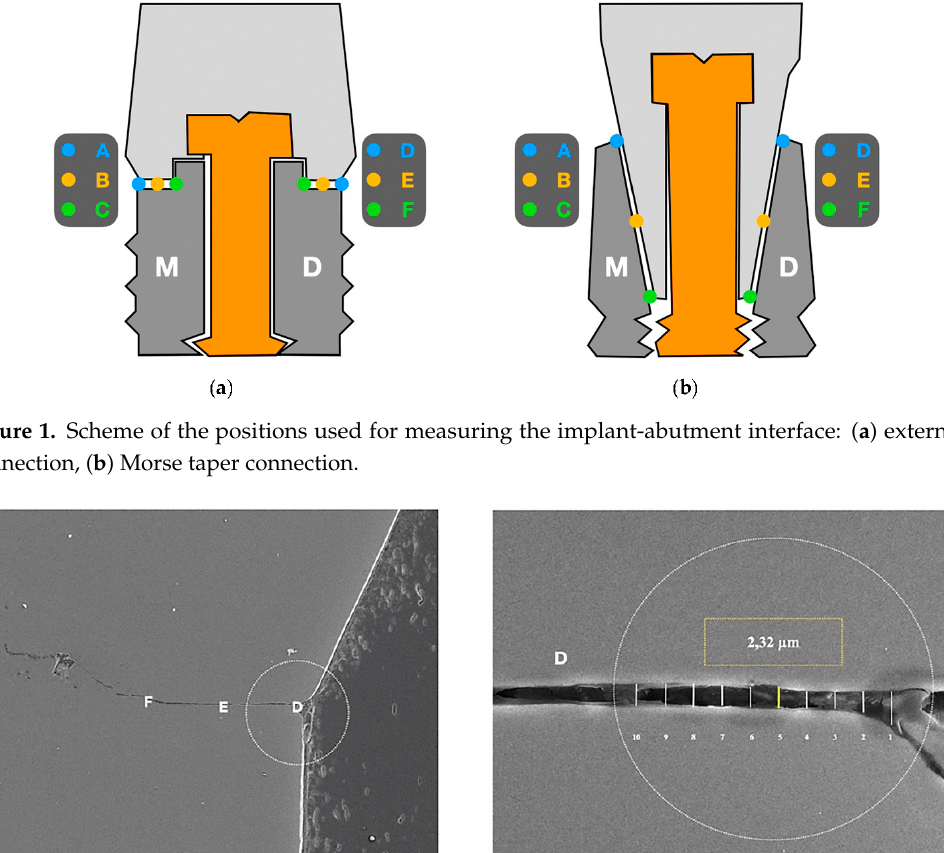
Figure 2. SEM images (1000×): ( a ) Reference points for the measurements in the external connection, ( b ) Detail of an edited image increasing the number of measurements per point.